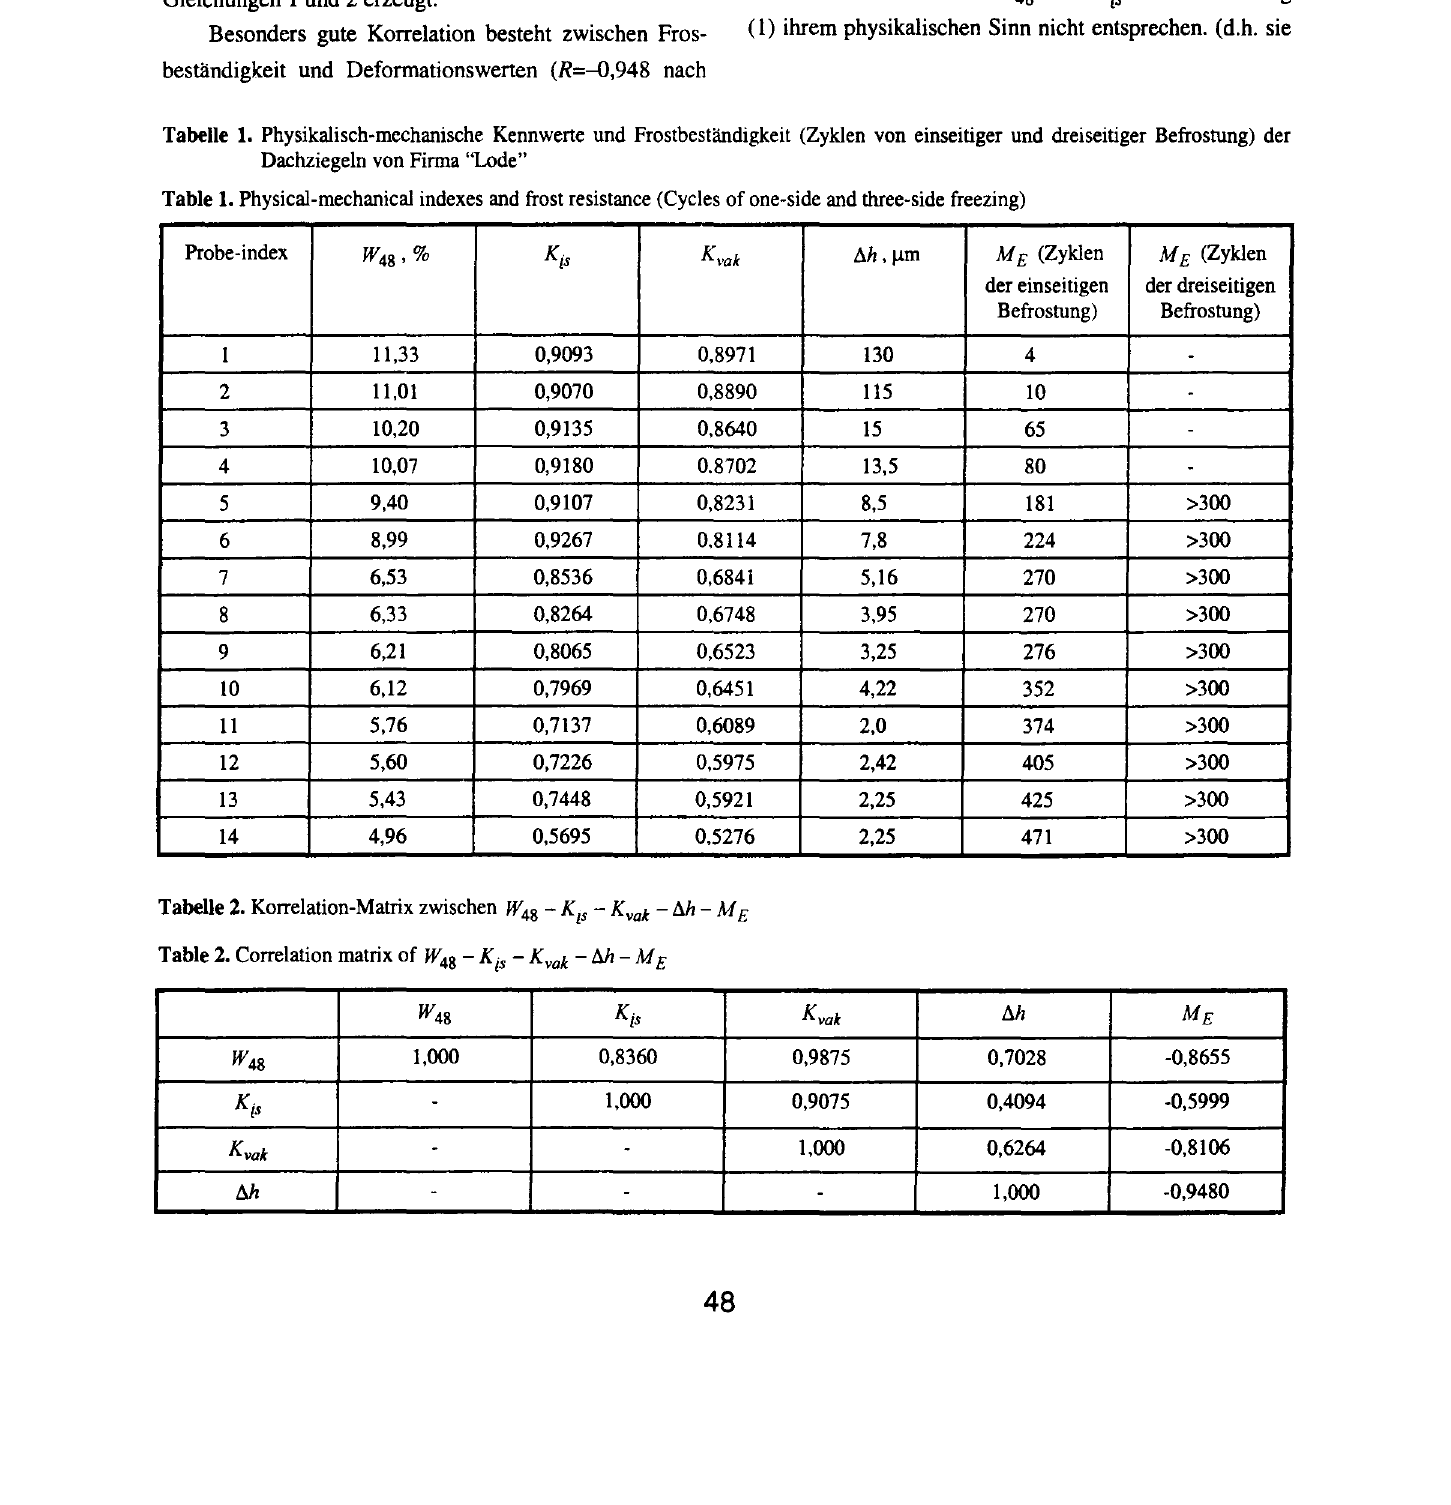
Table 1. Physical-mechanical indexes and frost resistance (Cycles of one-side and three-side freezing) Probe-index